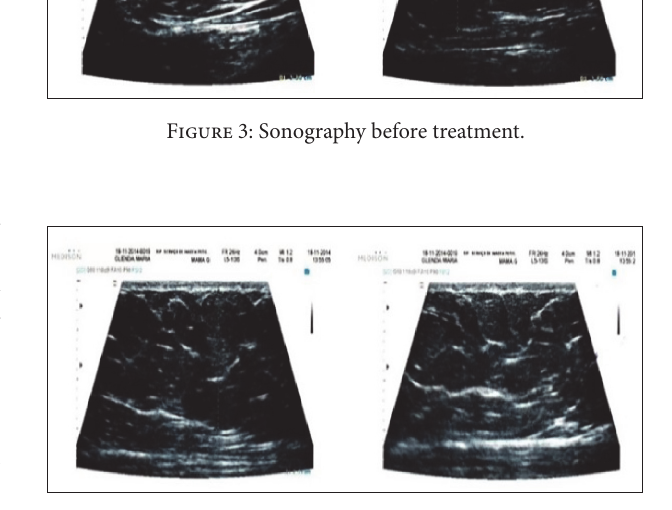
Figure 4: Sonography, 7 days after